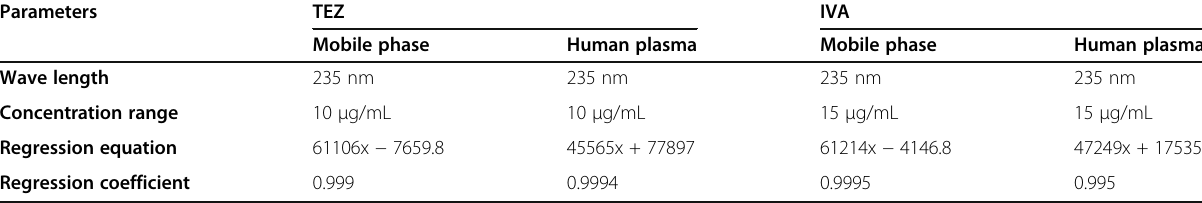
Table 1 Various parameters used in validation of Ivacaftor and Tezacaftor linearity studies